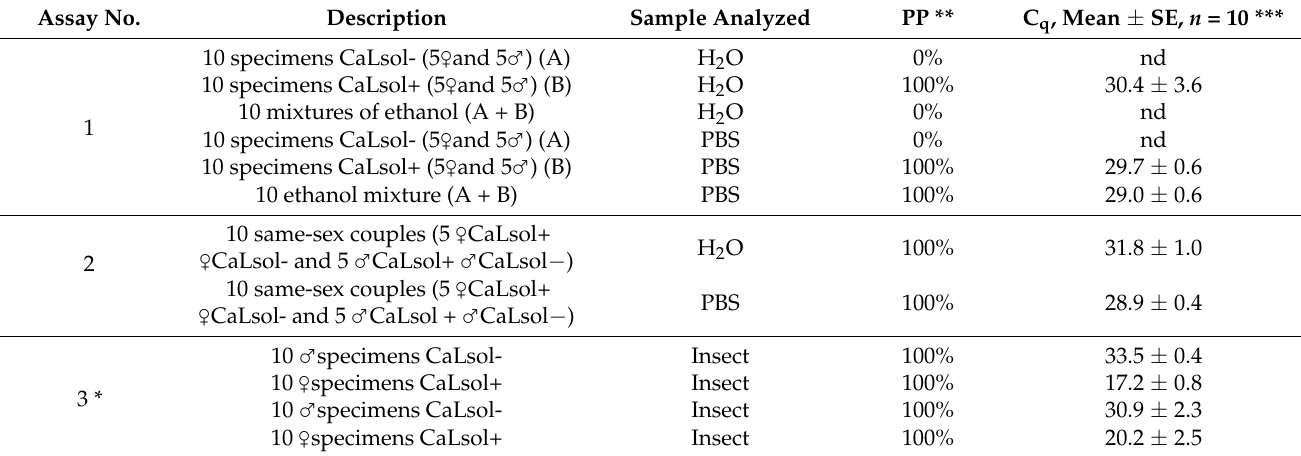
Table 9. Detection of CaLsol by qPCR analysis according to Li et al. (2009) in cross-contamination assays. Assay